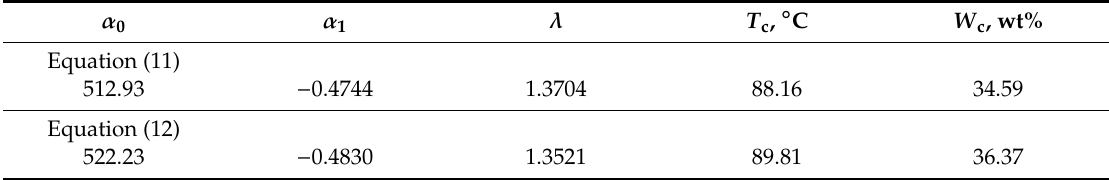
Table 3. Best fit parameters for the idebenone – hexane / methylene chloride (7:1 by volume) system estimated through fitting the experimental data of Lu et al. [5]. Parameters obtained using both the models for the first perturbative term of the Helmholtz free energy (i.e., η e ff through Equations (11) and (12)), are listed. Also given are the estimated critical temperature ( T c ) and critical concentration ( W c ). The calculations were performed with σ = 0.872